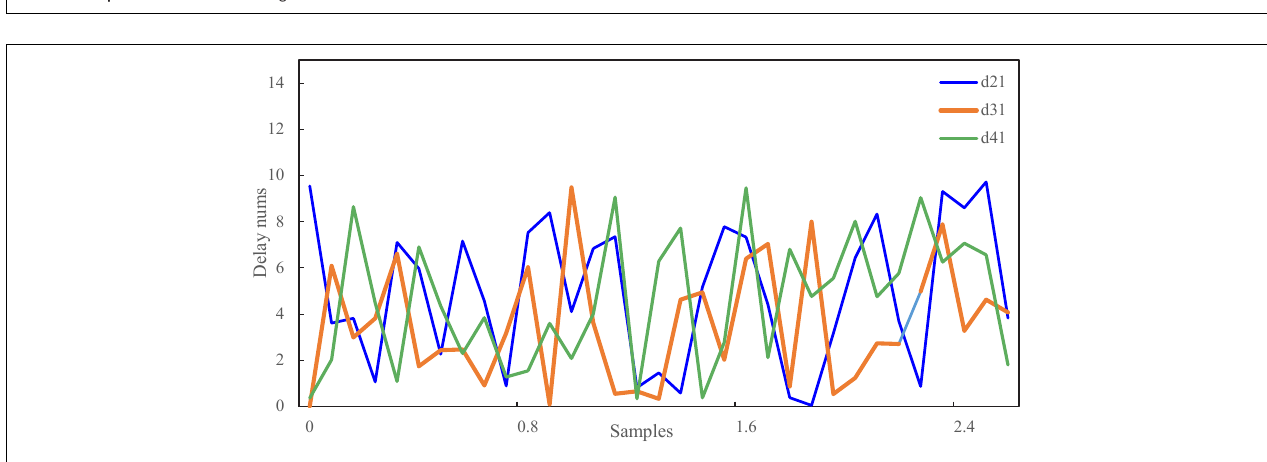
FIGURE 5 | Speech signal delay